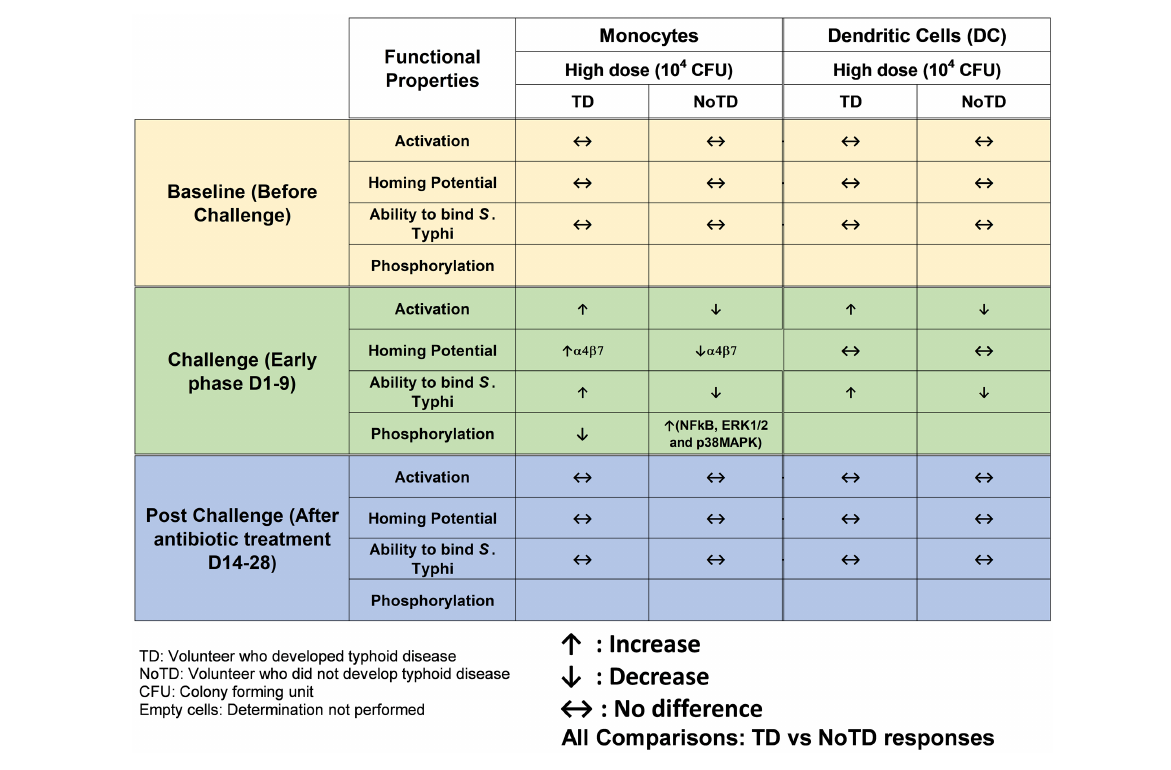
FIGURE 2 Characteristics of monocytes and dendritic cells (DC) in a typhoid CHIM. Summary of responses by monocytes and DC reported in Toapanta et al. (2015) and including comparisons between TD and NoTD at baseline (before challenge), early days after challenge (D1-9) and at later time points after challenge (D14-28). ↑ : Increase; ↓ : Decrease; ↔ : No